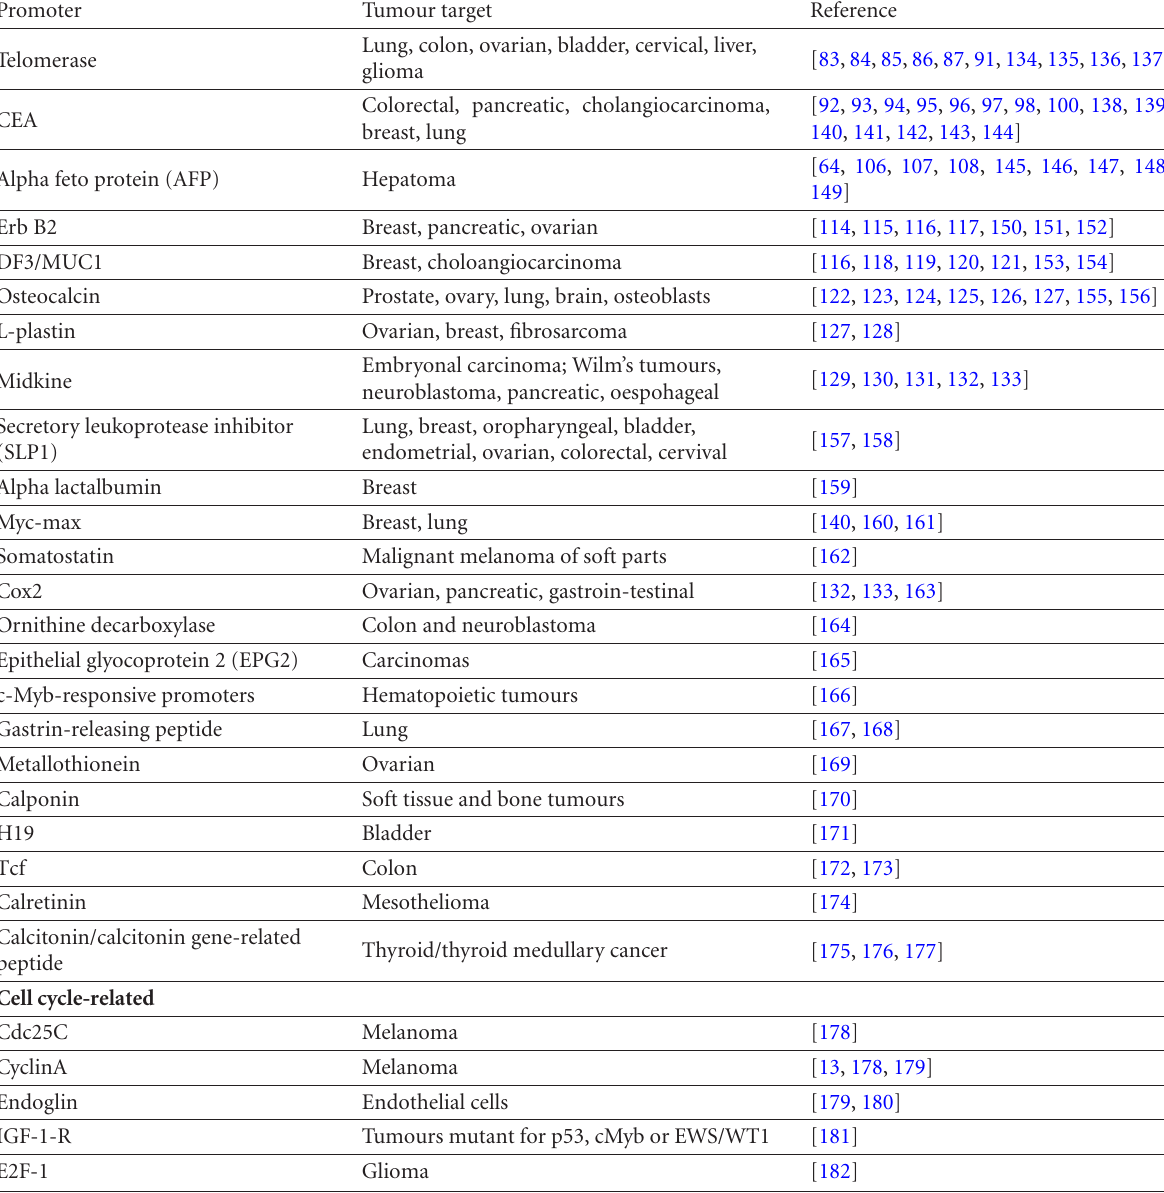
Table 2. Tumour-specific